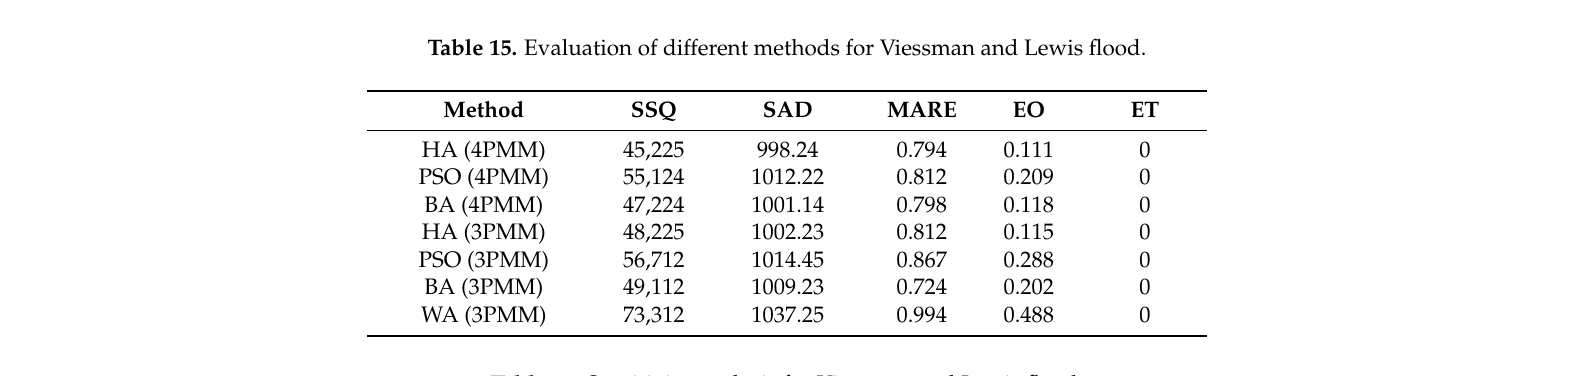
Table 16. Sensitivity analysis for Viessman and Lewis